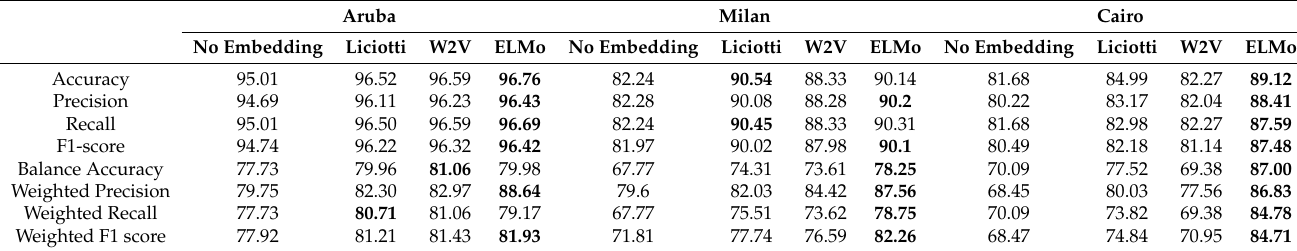
Table 7. Without and with embedding coupled with a Bi-LSTM Classifier. Aruba Milan